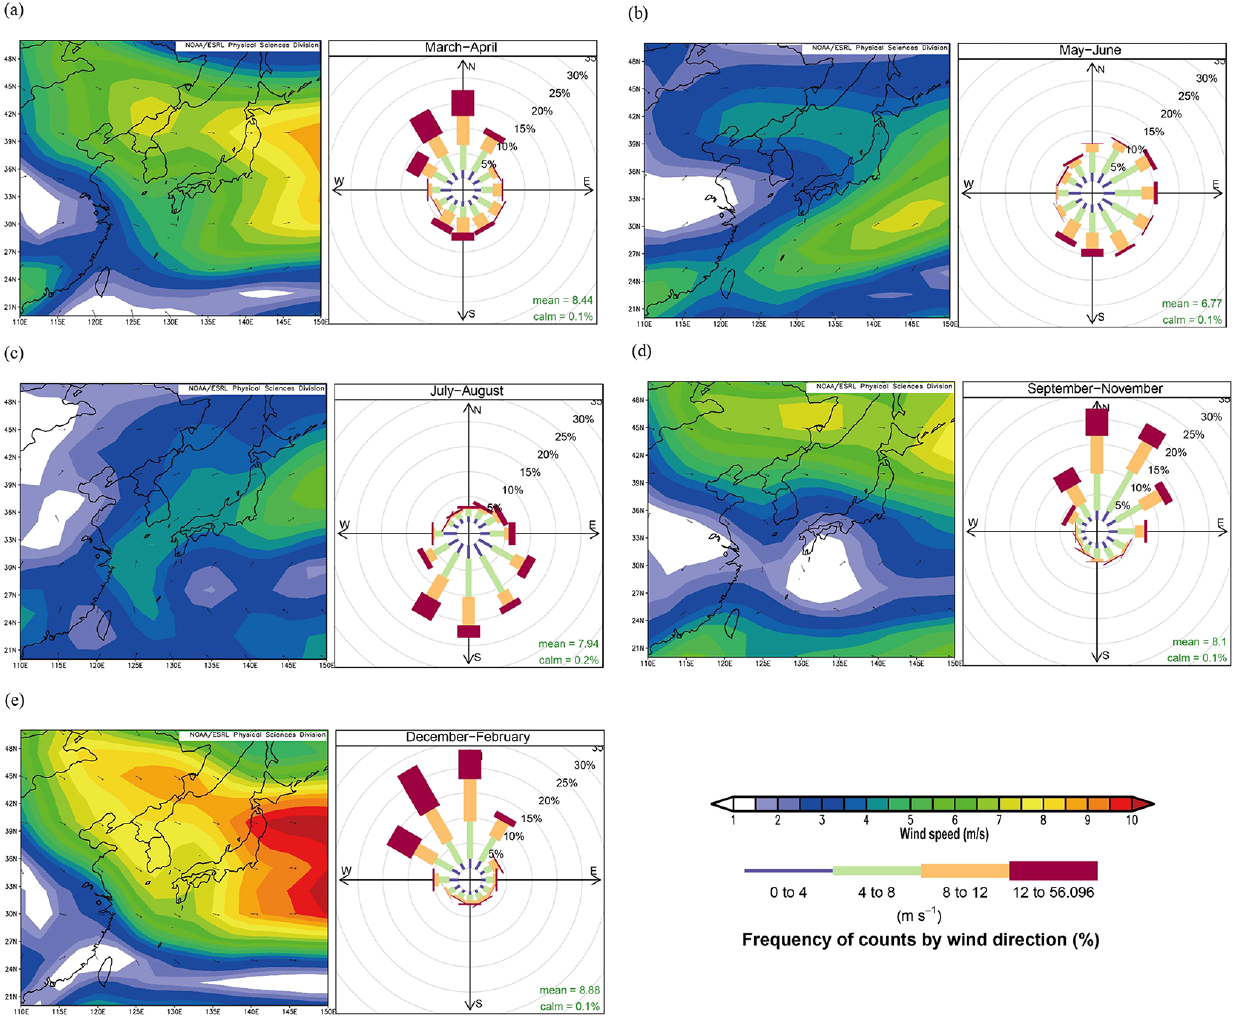
Figure 5. The left panel for contour maps presenting NCEP/NCAR Reanalysis wind speed in color and wind vector at 850mb in east Asia from 2004 to 2010 and the right panel for wind roses measured at IORS during (a) March–April, (b) May–June, (c) July–August, (d) September–November, and (e)